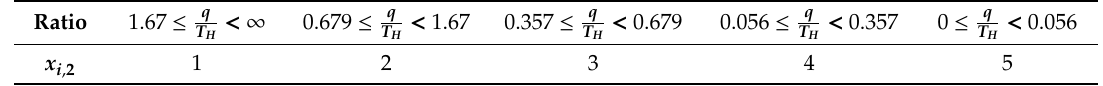
Table 2. Performance values x i ,2 for 2nd